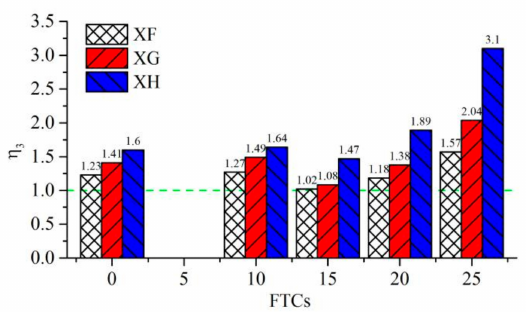
Figure 7. Values of η 3 under di ff erent